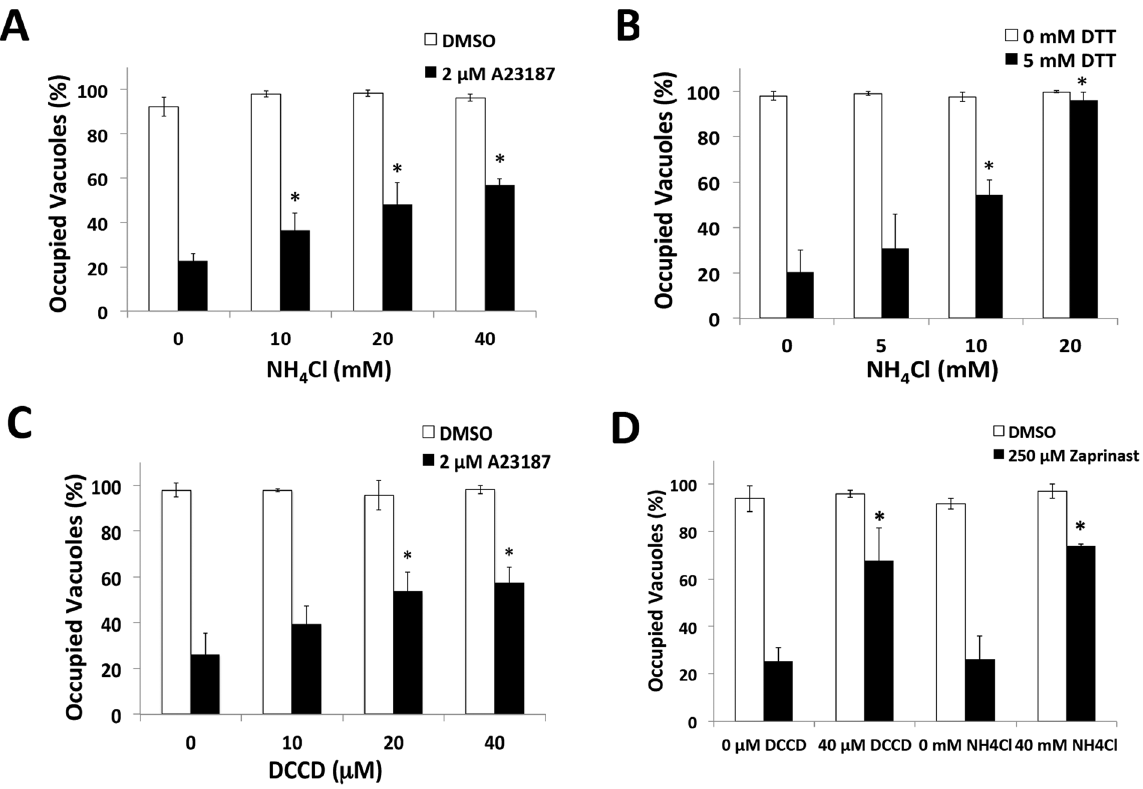
Figure 3. pH neutralization suppresses parasite egress. (A–D) Parasite egress quantified by immunofluorescence microscopy. Wild type (RH) parasites were allowed to replicate for 30 h (A23187, Zaprinast) or 35 h (DTT) prior to pre-treatment with or without inhibitor followed by vehicle (DMSO, buffer) or egress inducer (2 m M A23187, 5 mM DTT, 250 m M Zaprinast) with or without inhibitor for 2 min. Immunofluorescence was performed for parasites (SAG1) and parasitophorous vacuole (GRA7) and occupied vacuoles were quantified. (* p , 0.05, student’s t -test compared to A23187/DTT/Zaprinast alone). Graphs reflect the average and standard deviation of 3 independent experiment; * p , 0.05 by student’s t -test vs. A23187/DTT/Zaprinast with no